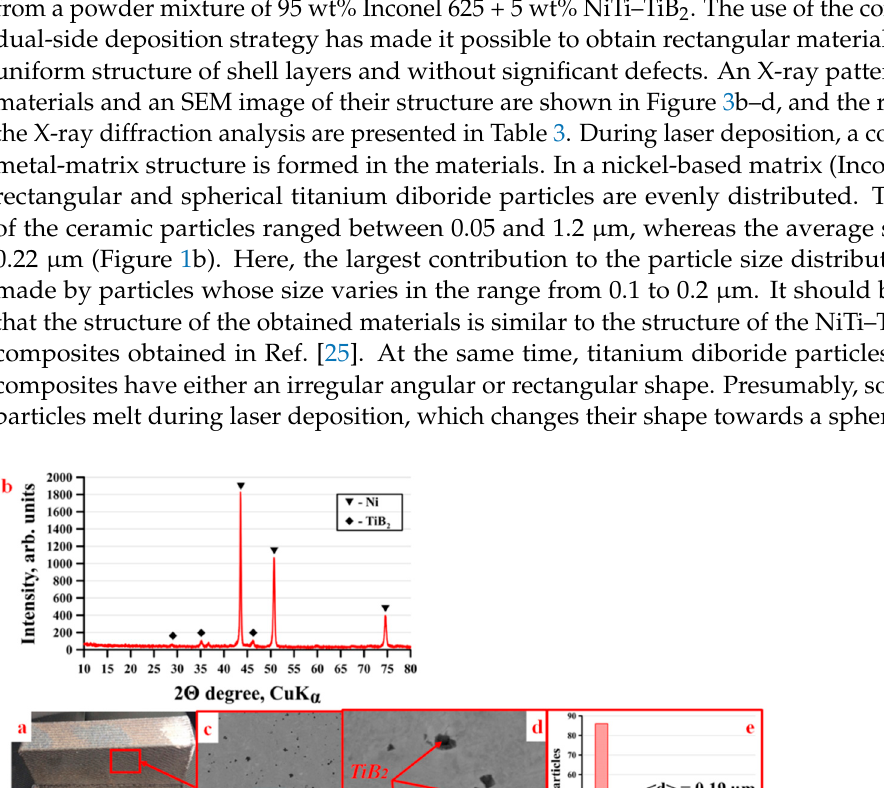
Table 3. Results of the X-ray diffraction analysis of the materials obtained by selective laser